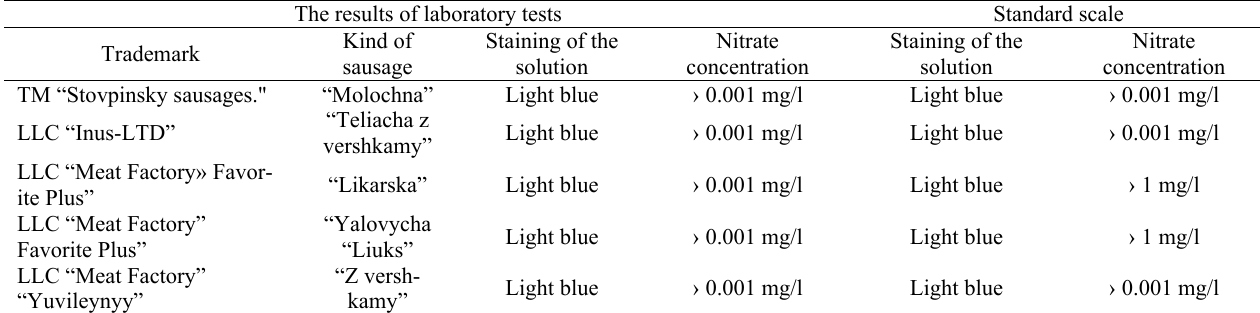
The results of the study of nitrate content in sausages The results of laboratory tests